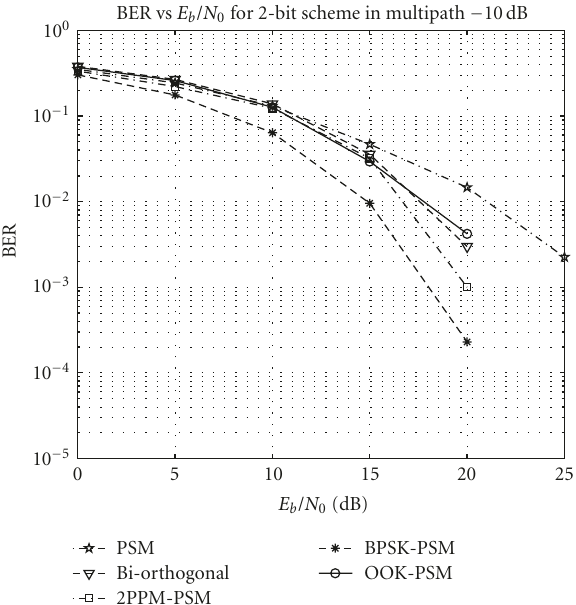
Figure 9: Performance of various modulation schemes for 2-bit symbols transmission in a multipath environments. The receiver assumes a RAKE-combination by considering all paths within − 10 dB of the strongest path. The schemes uses orthogonal pulses based on